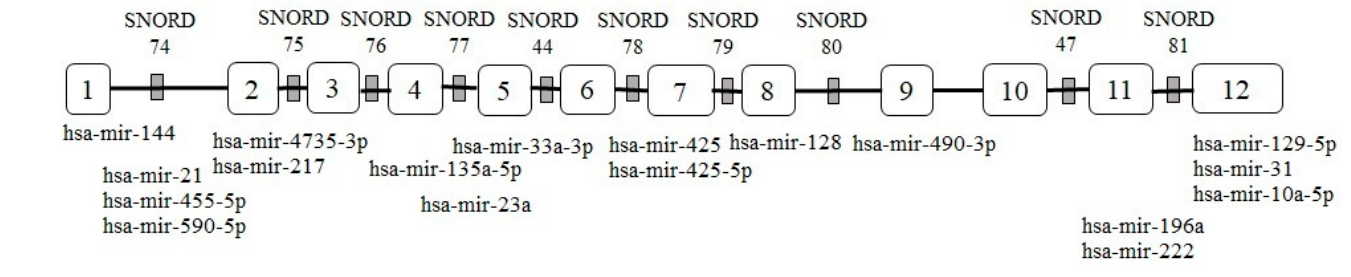
Figure 1. Diagram representation of GAS5 transcript (GenBank ID: NR_002578.3) with the sequence length of 656 nt encodes 10 snoRNAs within introns. The sponging regions of miRNAs predicted by miRcode [13] are located at exon 1 (hsa-mir-144), intron 1 (hsa-mir-21, hsa-mir-455-5p and hsa-mir-590-5p), exon 2 (hsa-mir-4735-3p and hsa-mir-217), exon 4 (hsa-mir-135a-5p), exon 5 (hsa-mir-33a-3p), intron 4 (hsa-mir-23a), exon 7 (hsa-mir-425 and hsa-mir-425-5p, exon 8 (hsa-mir-128), exon 9 (hsa-mir-490-3p), intron 11 (hsa-mir-196a and hsa-mir-222) and exon 12 (hsa-mir-129-5p, hsa-mir-31 and hsa-mir-10a-5p).